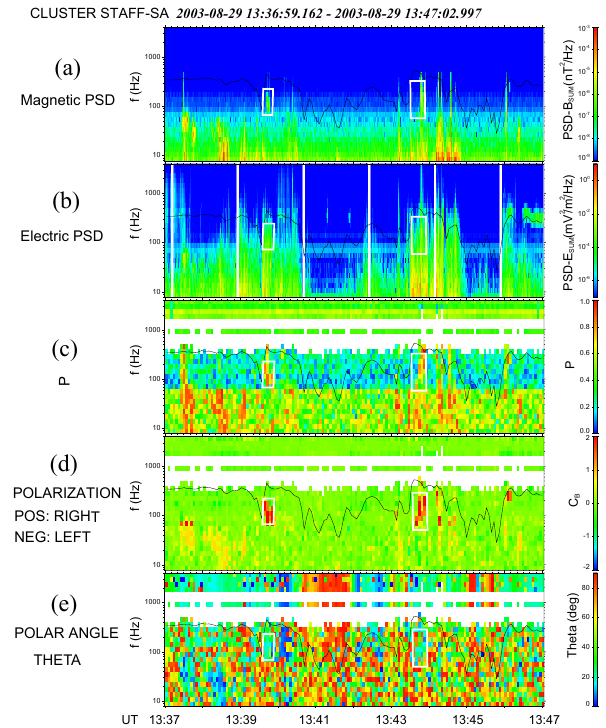
Fig. 6. Polarization analysis of waves from 8 to 4000Hz between 13:37UT and 13:47UT on Cluster-4. Note that the frequency scale is logarithmic on all panels. From top to bottom are: (a) power spectral density of magnetic fields; (b) power spectral density of electric fields; (c) planarity of polarization; (d) the sense of polar- ization and (e) the propagation angles of the waves with respect to ambient magnetic field. Black curve on all panels corresponds to the electron cyclotron frequency. The white rectangles show the whistler wave emissions around two